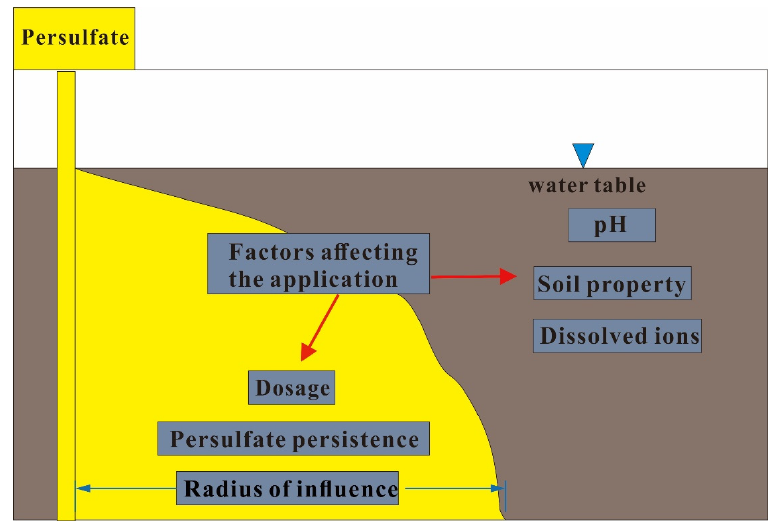
Figure 2. Factors affecting the application of persulfate in ISCO.